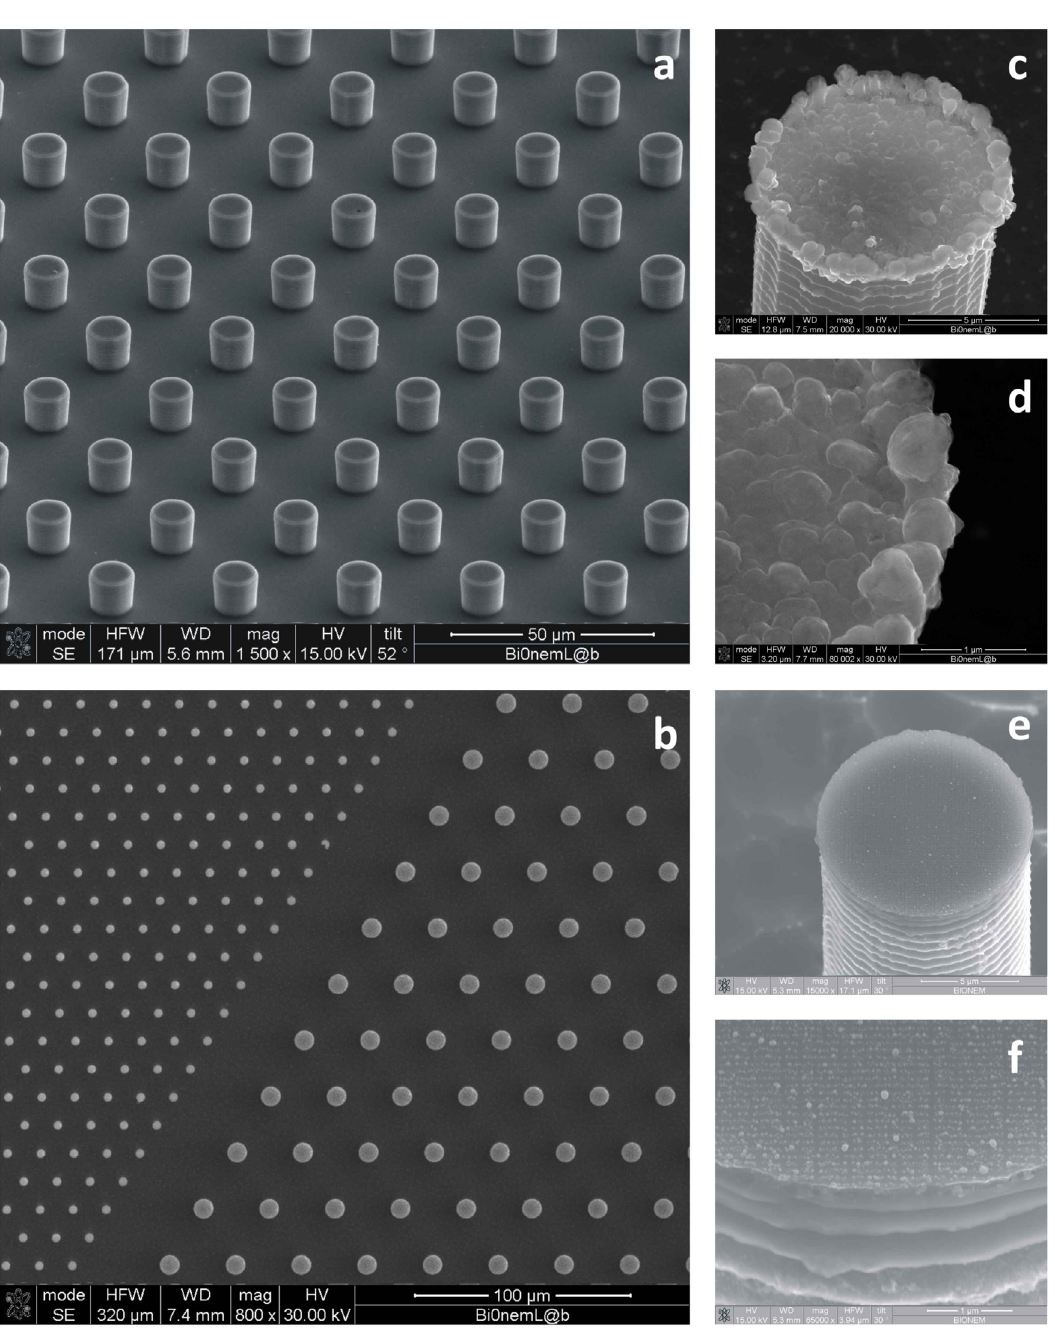
Figure 2. SEM micrographs of the textures of silicon micropillars ( a , b ); the top of those pillars can be tailored with random patterns of silver nanoparticles ( c , d ) or regular arrays of metallic nanodots ( e , f ) for surface-enhanced Raman scattering